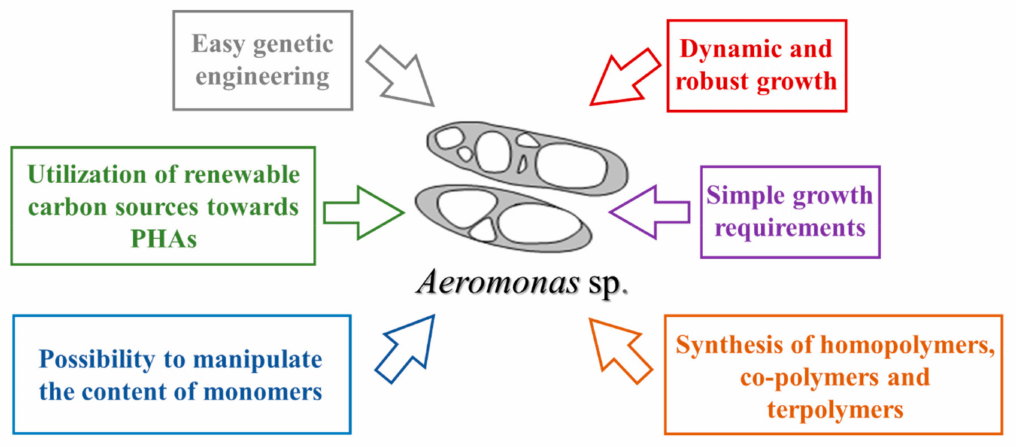
Figure 3. Advantages of using Aeromonas spp. for large scale production of